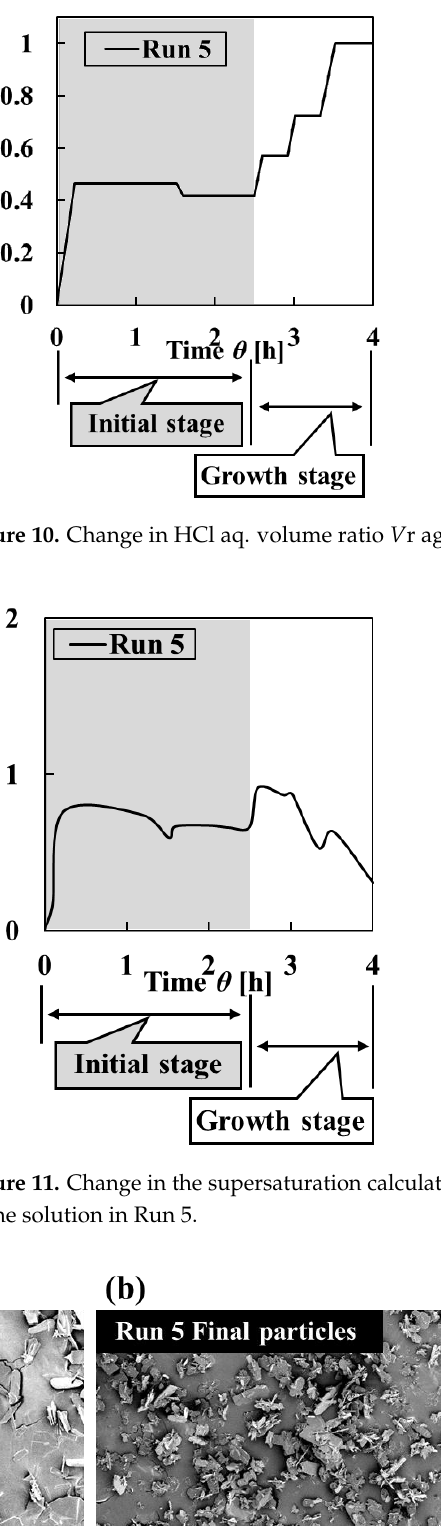
Figure 13. Dynamic variation in homogeneity and uniformity of distributions of particle size and crystal shape with the crystallization time in Run 5. 4. Conclusions In this study, we designed an operation method to improve the comprehensive uni- formity of crystalline particles by evaluating the dynamic variation in the uniformity of distributions of particle size and crystal shape using homogeneity as a novel index term. Since the ratios of the uniformities of particle sizes and crystal shapes constituting the homogeneity of crystalline particles varied dynamically, it showed the possibility of pro- posing the operation method to improve uniformity. The experiment results showed that there were differences in the variation of homo- geneity between continuous and intermittent operation. In addition, the differences could be estimated by the effect of supersaturation (ln S ). Comparing the results of the intermit- tent operations with different changes in supersaturation over time, it was found that a significant difference in the ratios of the uniformities constituting the homogeneity at each crystallization stage in the intermittent operation was observable. In addition, it was revealed that the supersaturation condition in the intermittent op- eration should combine the features of each stage for improving the homogeneity of the final particles. In particular, in the initial stage of intermittent operation, modulation op- eration with a dissolution process was necessary to increase the uniformity of particle size, while in the growth stage, raising the number of times of adding solution was necessary to increase the uniformity of crystal shape. Consequently, we found that the concept of the homogeneity could be used to increase the uniformity of both crystal shape and par- ticle size in the reaction crystallization.